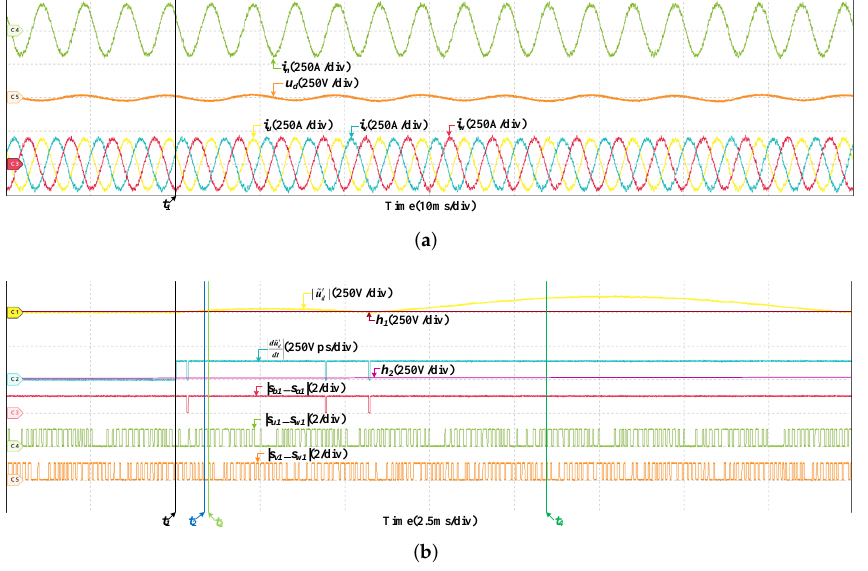
Figure 11. HIL results when the offset fault occurs in S Cn at 300 km/h. ( a ) The results of the grid current, DC-link voltage and stator currents. ( b ) The results of fault